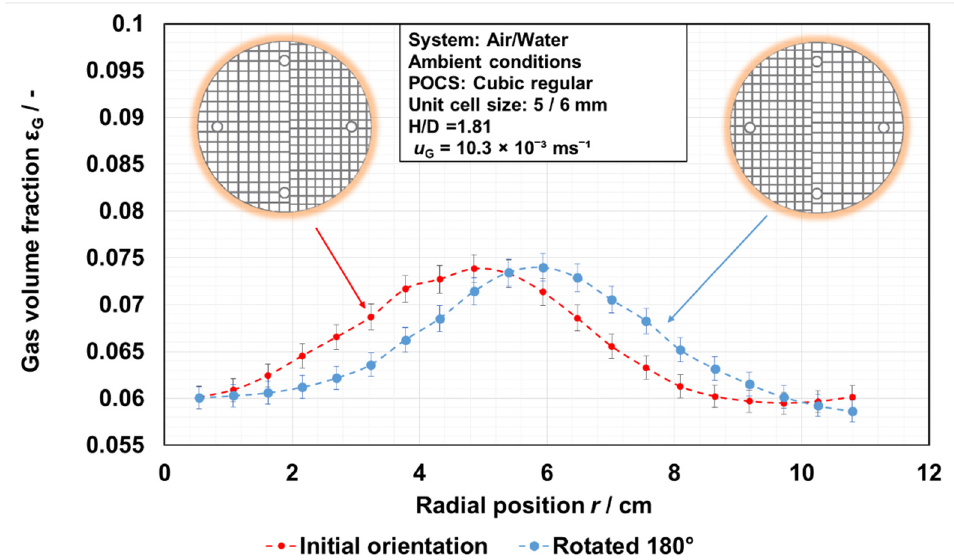
Figure 8. Averaged radial gas holdup profiles of the modified structure, in initial orientation ( red ) and rotated by 180° ( blue ).